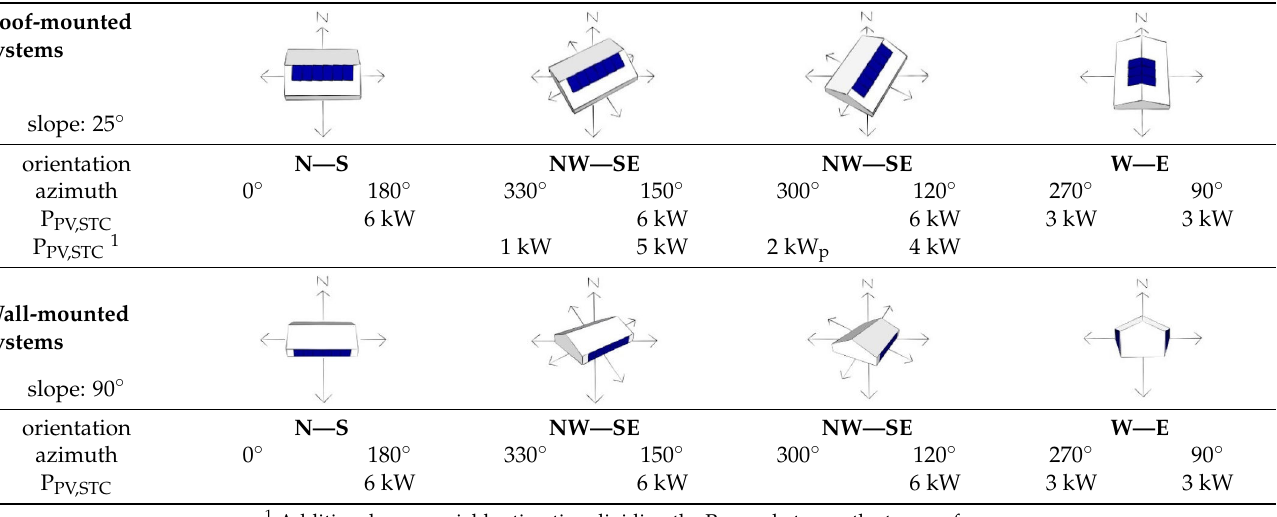
Table 2. Orientation and nominal peak power of PV systems